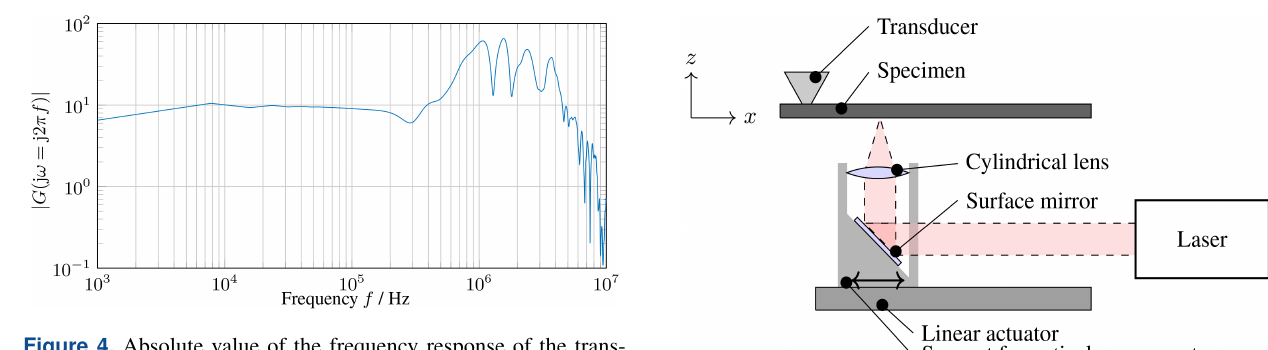
Figure 4. Absolute value of the frequency response of the trans- ducer.